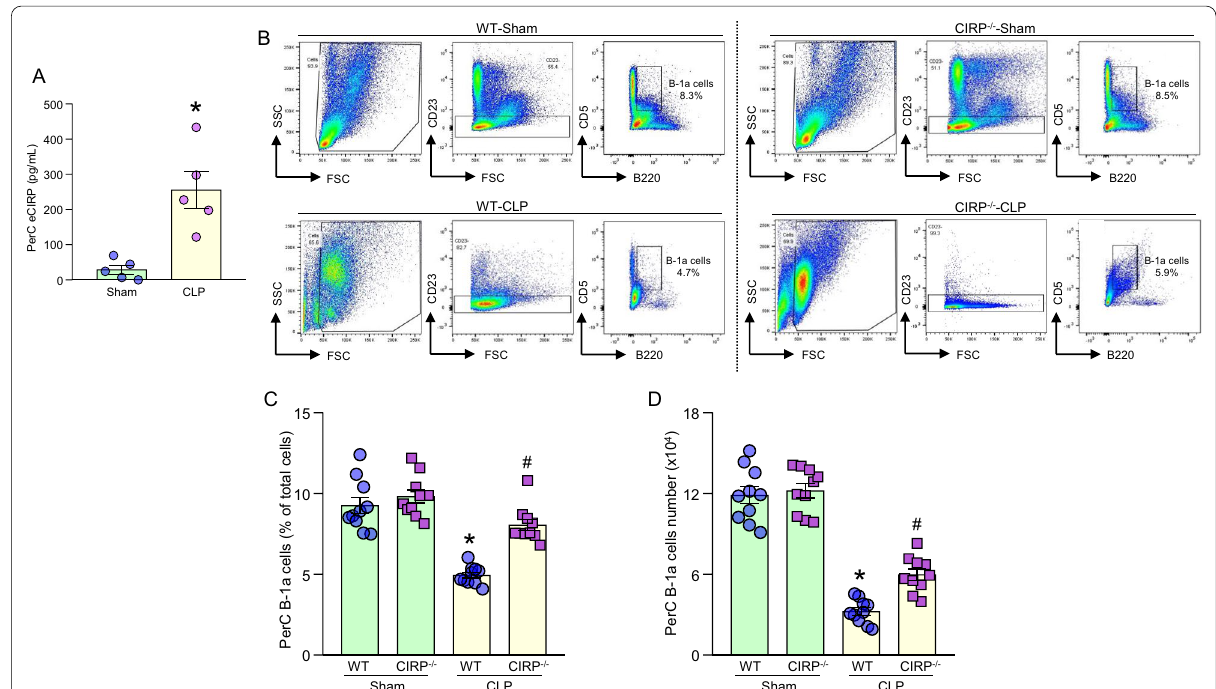
Fig. 1 Intraabdominal sepsis results in a loss of PerC B-1a cells, while CIRP − / − mice are protected from the loss of B-1a cells after sepsis. A After 20 h of CLP, peritoneal cavity lavage samples were collected. PerC lavage eCIRP concentration was assessed with ELISA. Data are expressed as means SE (n 5–7 mice/group). The groups were compared by Student’s t-test (*p < 0.05 vs. sham mice). WT and CIRP − / − mice were randomly ± = assigned to sham or CLP groups. 20 h after surgery, PerC lavage samples were collected for analysis. B Representative dot blots of the gating strategy of B-1a cells of sham and CLP mice are shown. C, D Status of B-1a cell’s frequencies (%) and numbers after surgery are shown. Data are expressed as means SE (n 10–14 mice/group). The groups were compared by one-way ANOVA and Student–Newman–Keuls (SNK) method ± = (*p < 0.05 vs. WT sham and # p < 0.05 vs. WT CLP